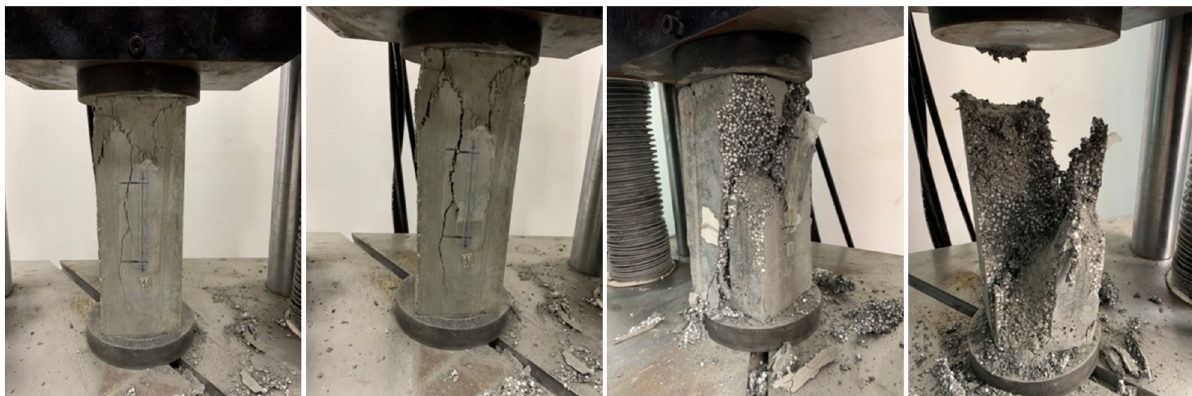
Figure 6: Failure mode of group M